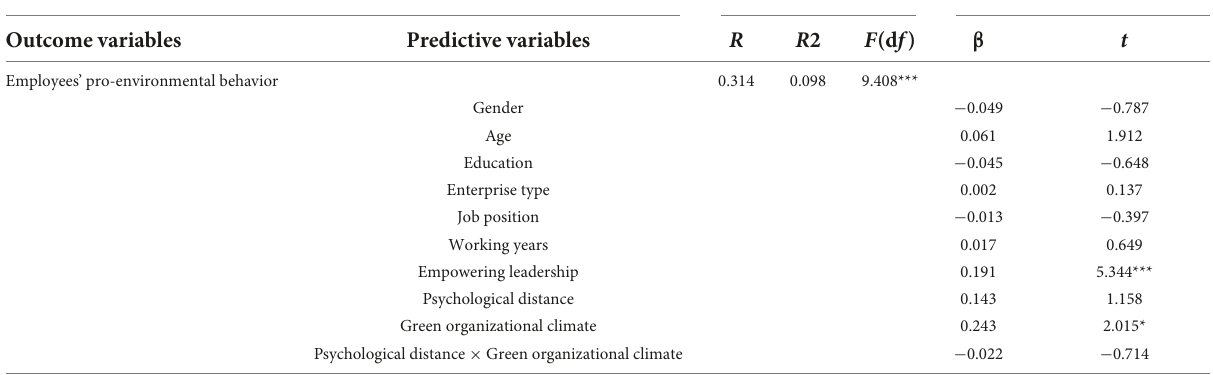
TABLE 6 Moderating effect test of green organizational climate